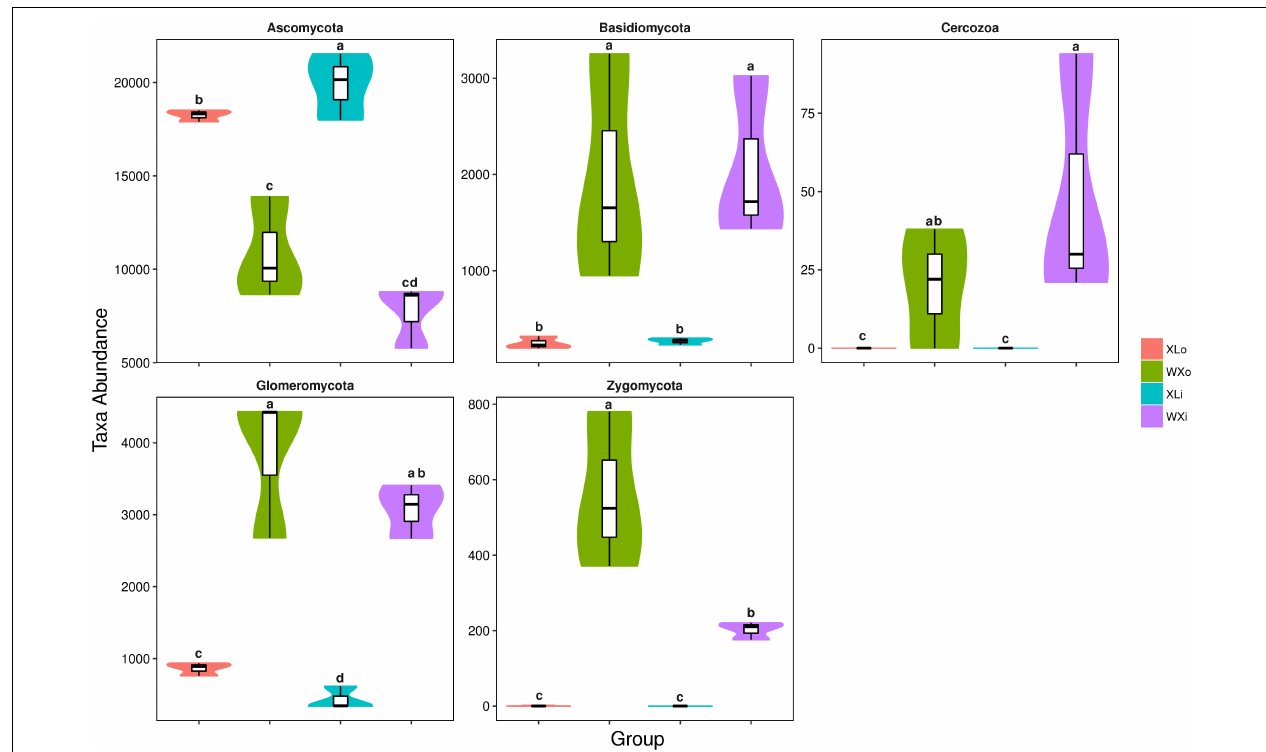
FIGURE 3 | Taxonomic profiles of statistically significant fungi at the phylum level. Different letters indicate significance at p <